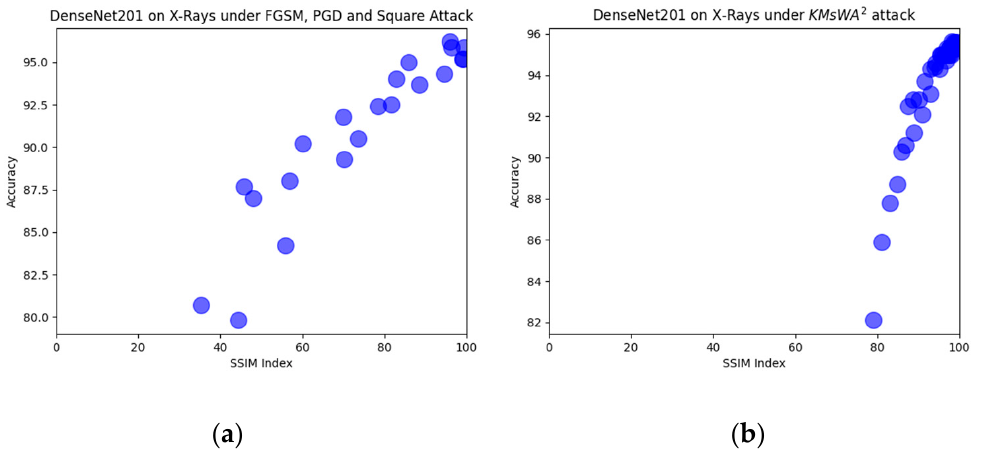
Figure 11. Scatter plots for DenseNet201 in X ‐ rays under ( a ) FGSM, PGD, Square Attack, and ( b ) KMsWA 2 attack .